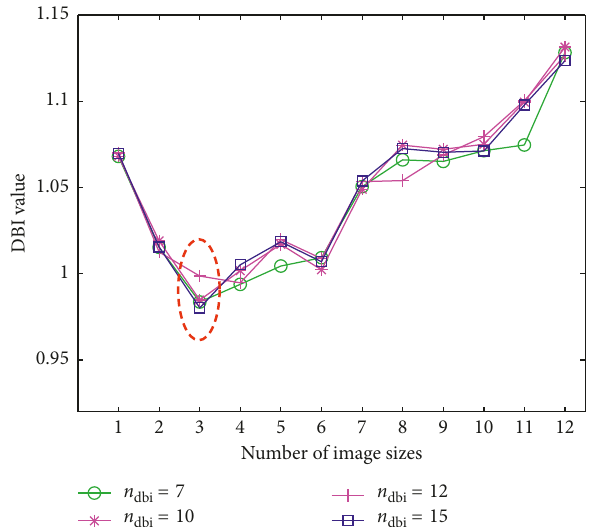
Figure 12: Experiment II: the DBI values for different image sizes.